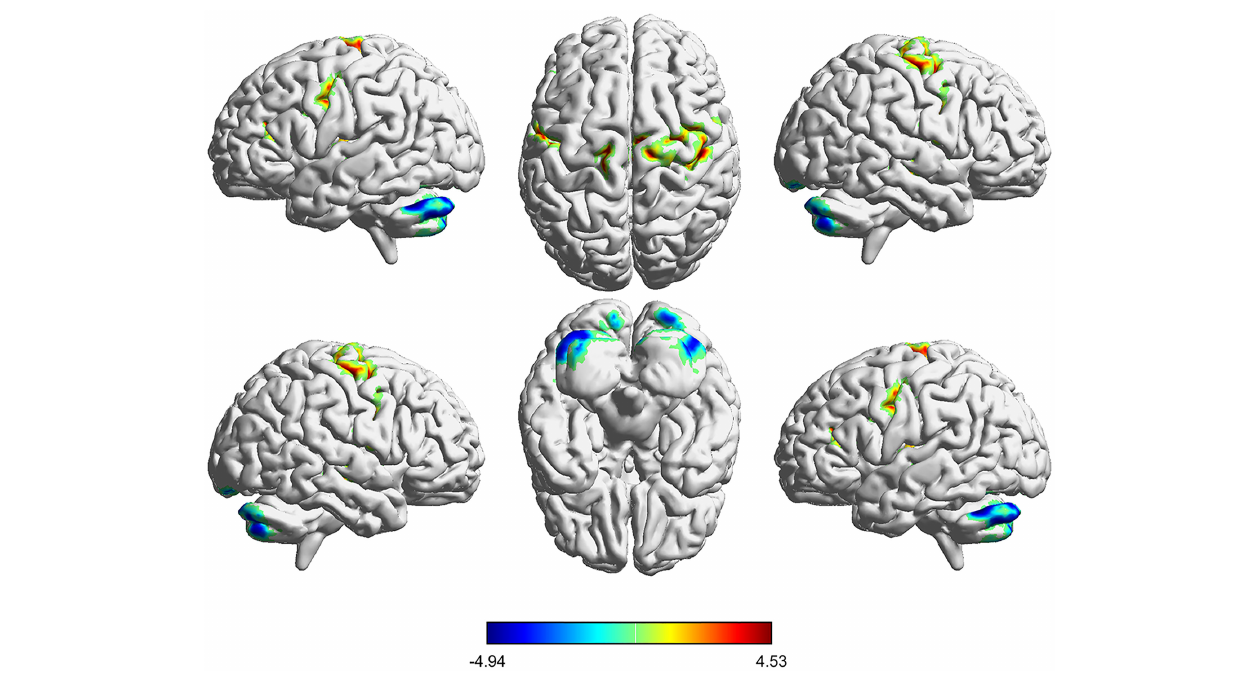
FIGURE 3 | Voxelwise comparison of DC between pre-CPAP OSA and post-CPAP OSA. Brain clusters showing a significant difference in degree centrality (DC) between OSA patients before and after CPAP treatment (cluster-level p < 0.01, GRF correction). Hot color (cool) indicates significantly increased (decreased) DC in the post-CPAP